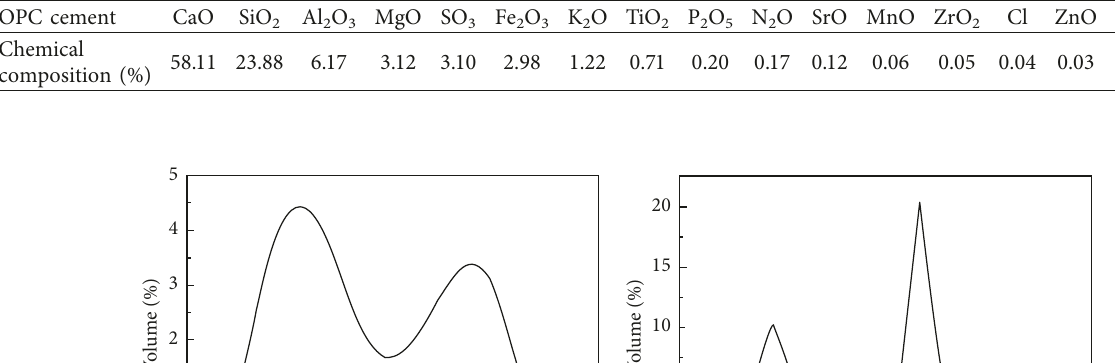
Table 2: Chemical composition of OPC cement.